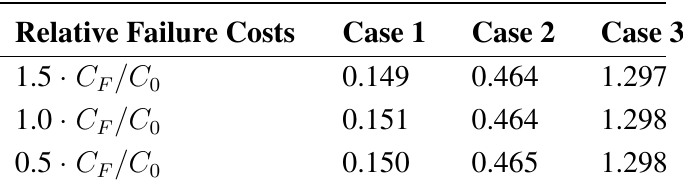
Table 9. Profitability W for different development stages (cases) and different relative expected failure costs. C : expected cost in the case of failure; C F